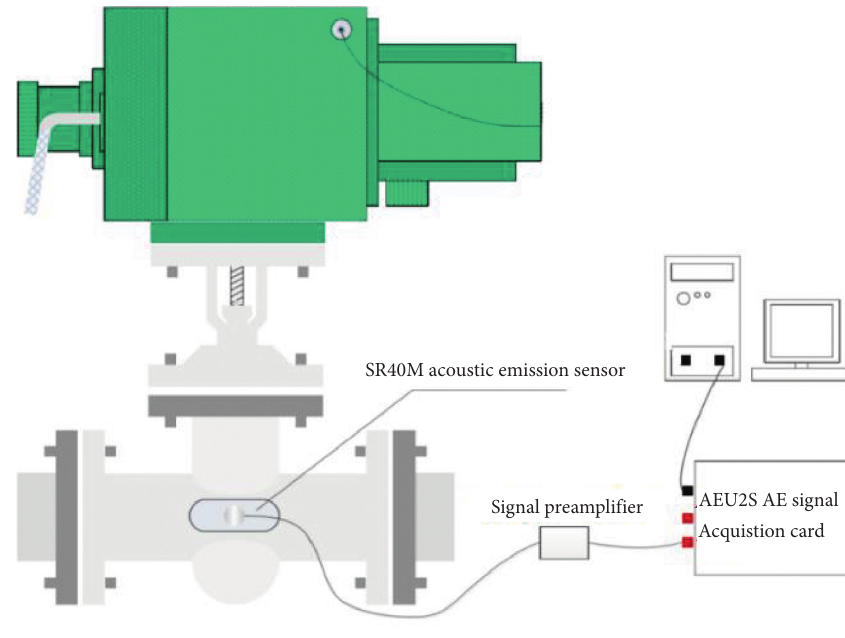
Figure 6: Arrangement of acoustic emission sensors on electric gate